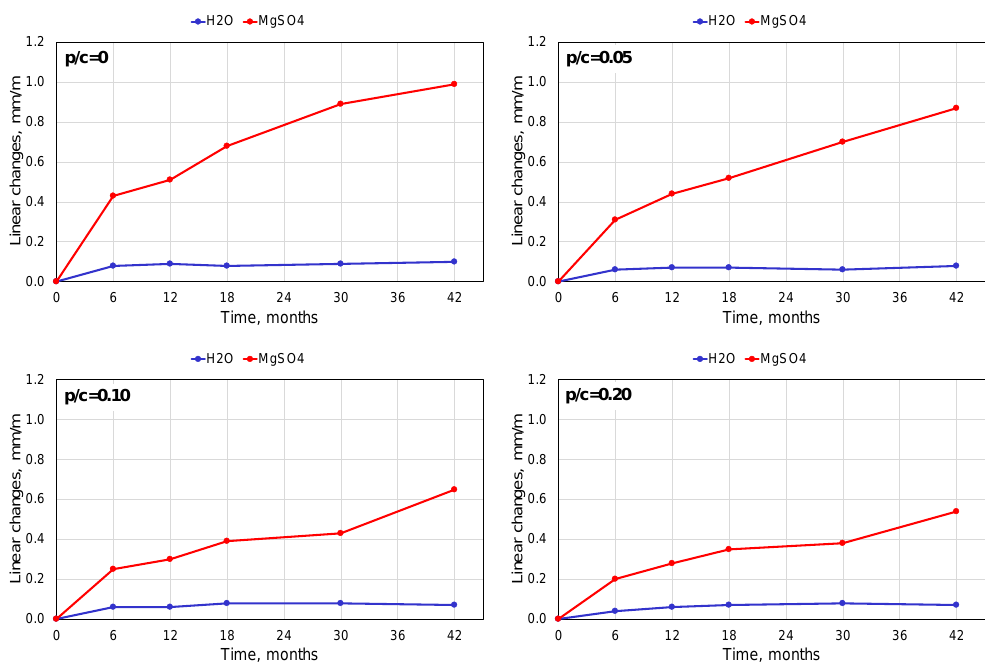
Figure 1. Elongation of mortar specimens exposed to 5% MgSO 4 solution and distilled water. The changes in length of the specimens stored in water were almost negligible, independent of the level of polymer addition. However, when exposed to the 5% MgSO 4 solution, the mortar specimens showed elongation that increased with the time of exposure. The changes were significant in spite of using Portland cement with enhanced sulphate resistance (MSR). The polymer addition improved mortar performance in such circumstances. The analysis of the results showed that the Materials 2019 , 12 , x FOR PEER REVIEW elongation diminished with increasing polymer content. The relative differences in elongation between the mortar with the polymer-cement ratio of 0.20 and that containing no polymer were similar for various times of exposure, and were roughly close to 50%. For instance, after 6 months of exposure, the absolute difference was equal to 0.23 mm/m, which meant a decrease by 53%, while after 42 months, the absolute difference was equal to 0.45 mm/m, which meant a decrease by 45.5% (Figure 2).